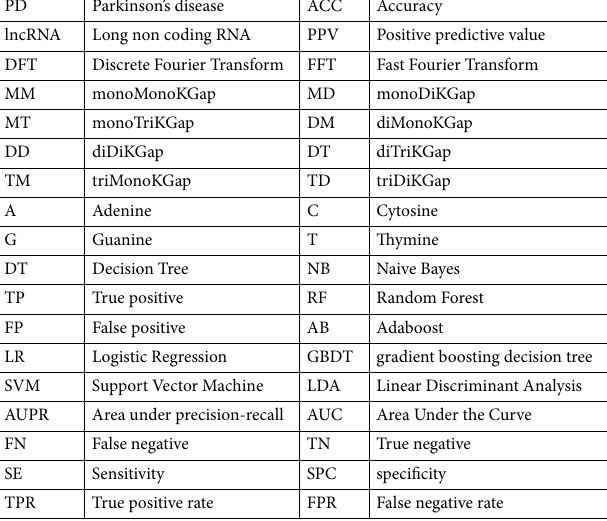
Table 1. The used abbreviations.